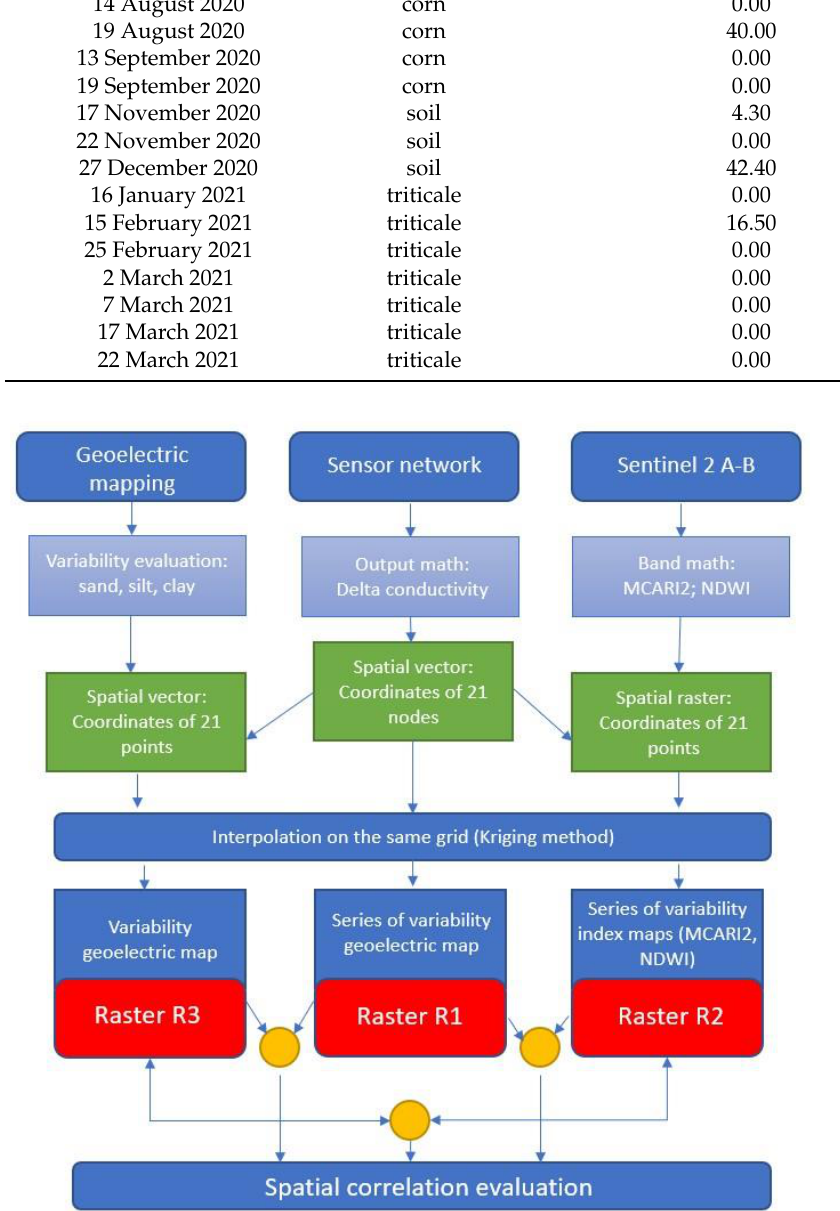
Figure 3. Flow diagram of the correlation study. The data were subjected to geostatistical analysis using the “R” statistical software. The values coming from the three sources, with the same coordinates for construction, were interpolated with the kriging method through the krige function of the gstat package of R, using a regular grid of 5 m × 5 m points in the quadrilateral defined by the area observed by the sensor network, to observe its distribution in